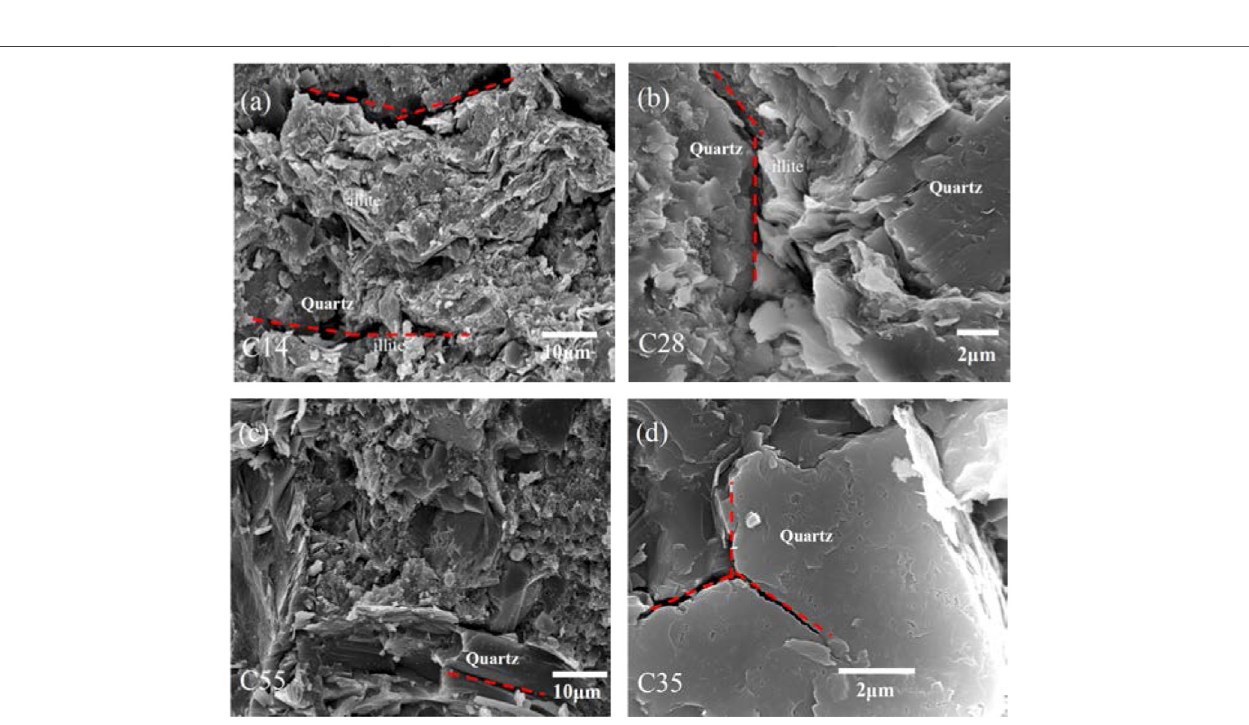
FIGURE 10 | Microscopic crack characteristics of the typical shale samples after fracturing. (A) Microscopic crack characteristics of sample C14. (B) Microscopic crack characteristics of sample C28. (C) Microscopic crack characteristics of sample C35. (D) Microscopic crack characteristics of sample C55.